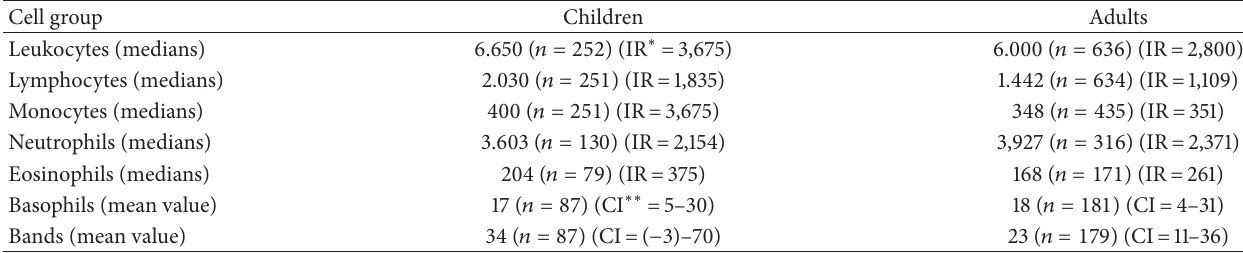
Table 4: White blood cells per 𝜇 L in children and adults.